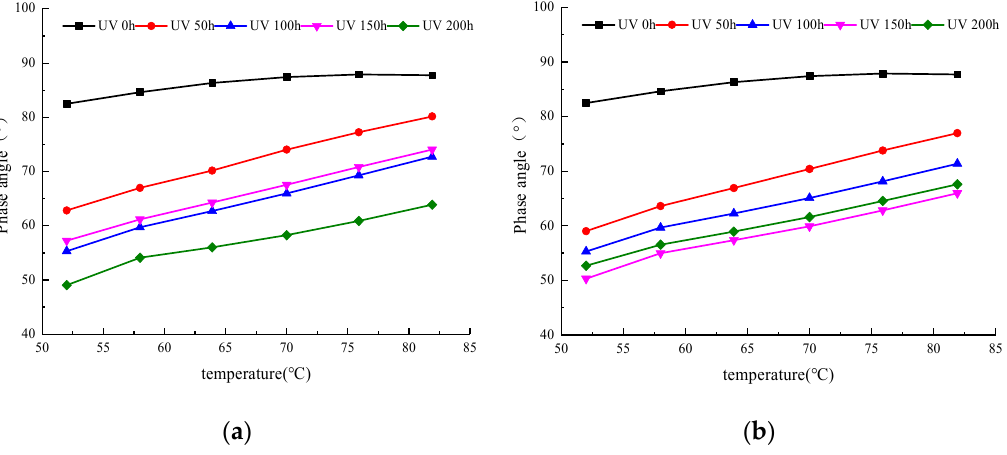
Figure 6. Phase angle of WMA. ( a ) Oxygen isolation conditions. ( b ) Oxygen ‐ containing conditions.